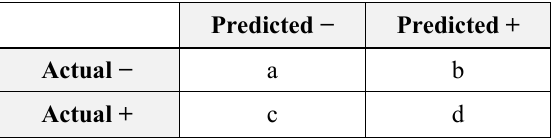
Table 2. Confusion